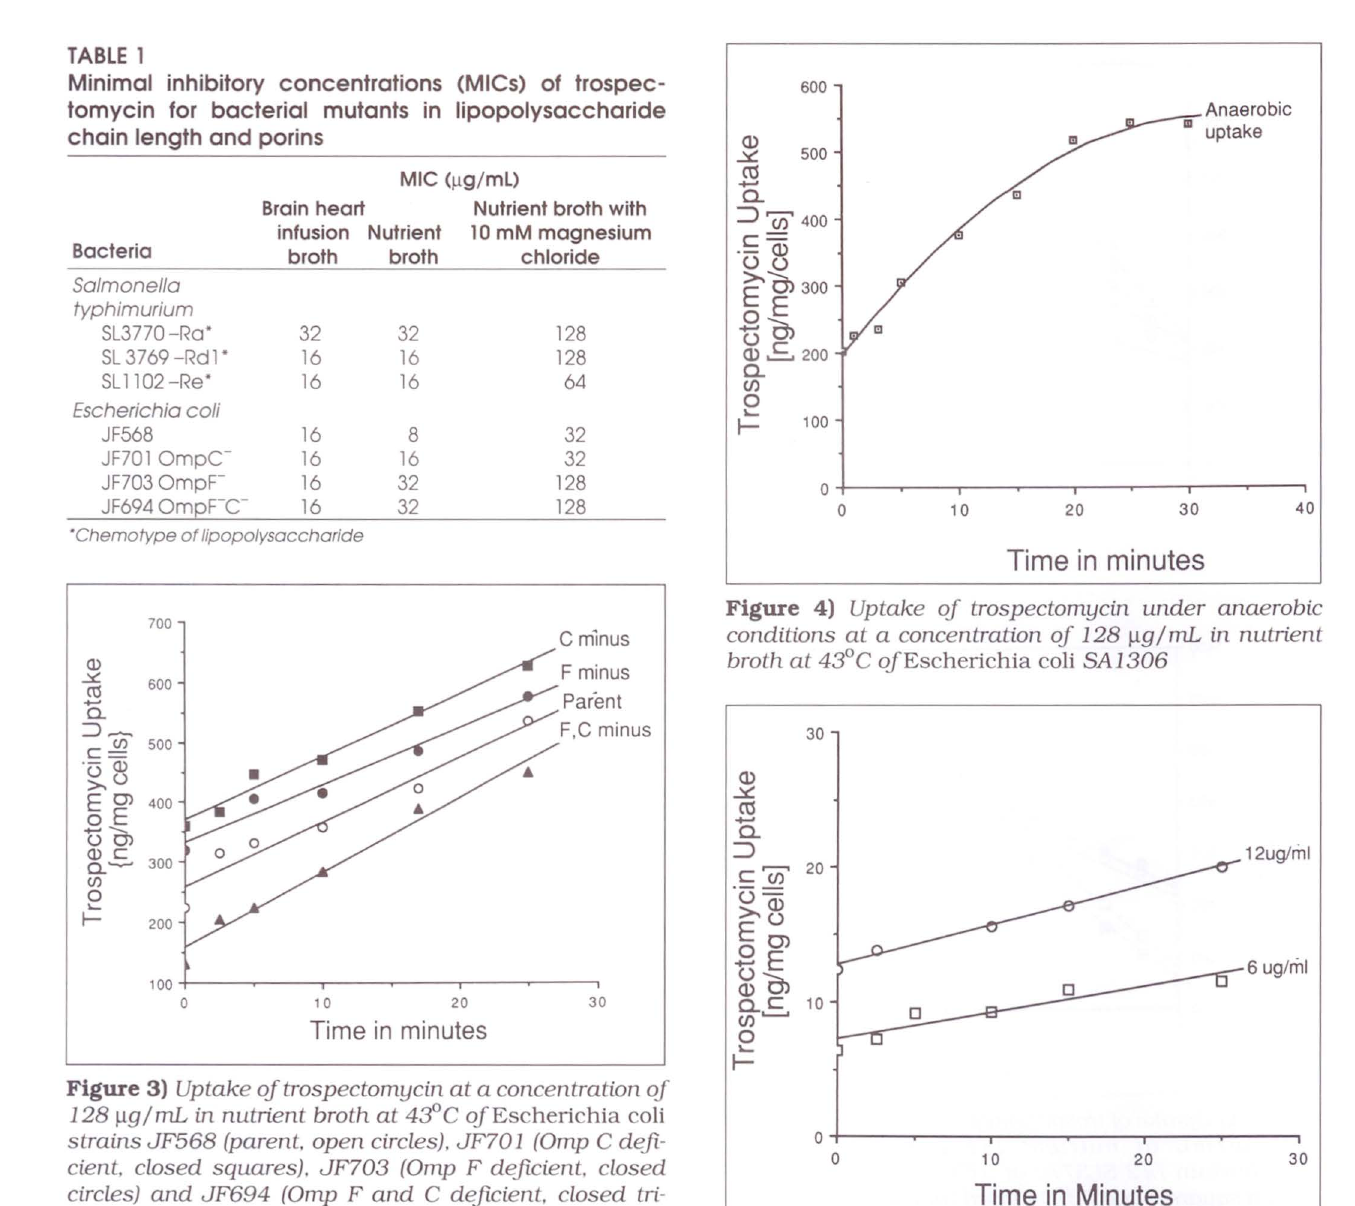
TABLE 1 Minimal inhibitory concentrations (MICs) of trospec tomycin for bacterial mutants in lipopolysaccharide chain length and porins